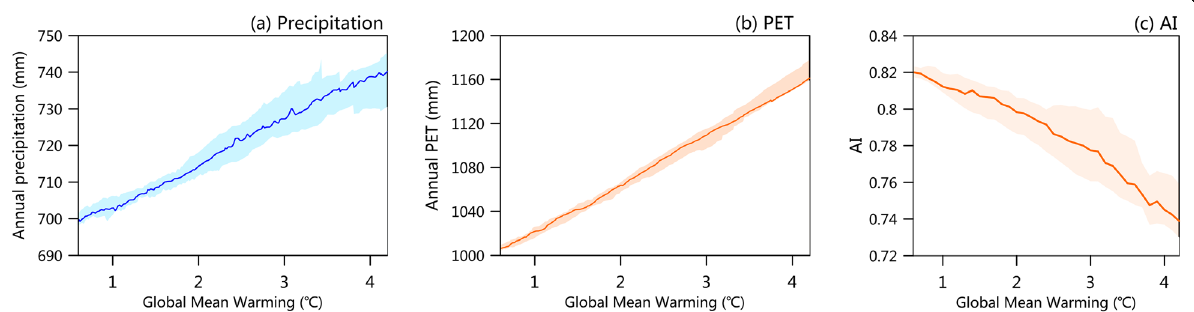
Fig. 4 Asian mean annual precipitation, PET, and AI as a function of warming level. The solid line is the multi-model mean, and the shaded area is the interquartile range